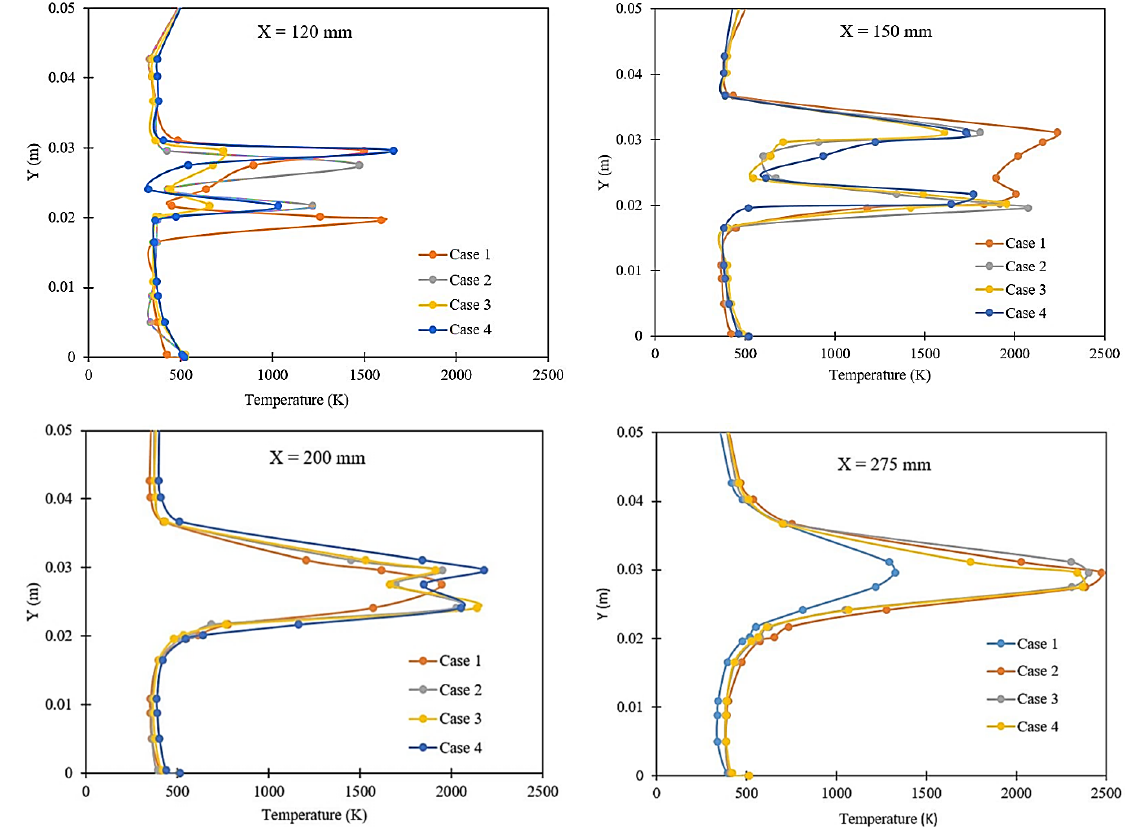
Figure 11. Temperature profiles across the combustor along the axial direction at X = 120 mm, X = 150 mm, X = 200 mm and X = 275 mm.